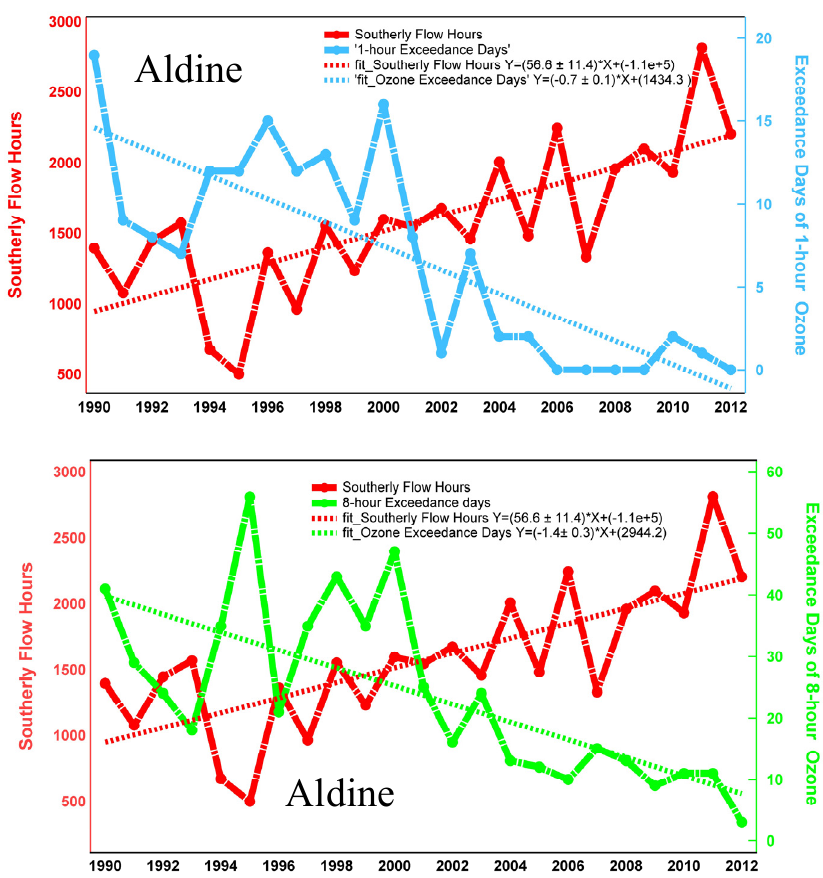
Figure 3. 1-h and 8-h exceedance days as a function of annual southerly flow hours per year at the Aldine